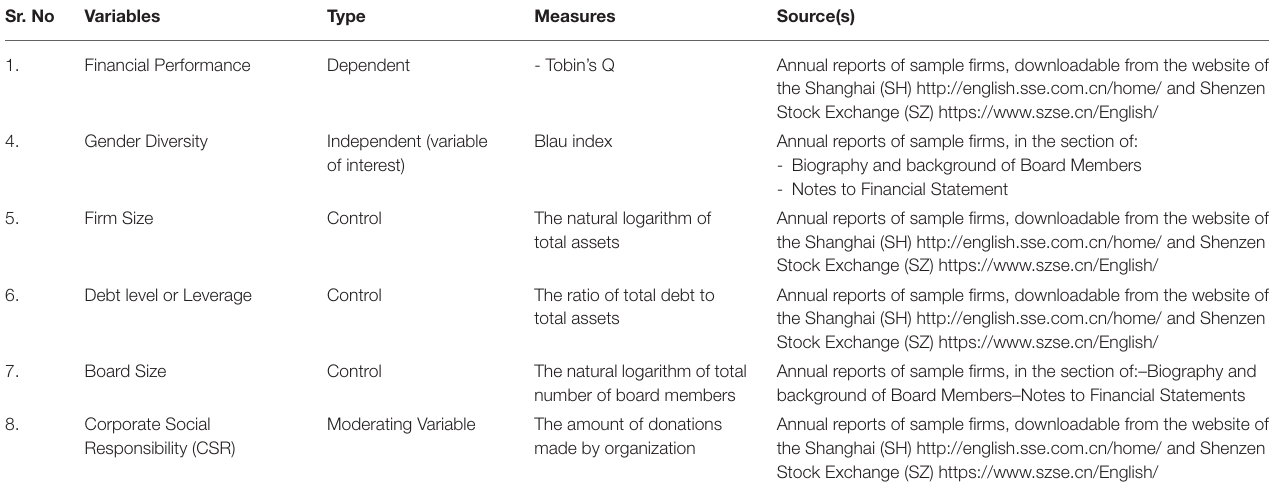
TABLE 1 | Measurement of constructs.